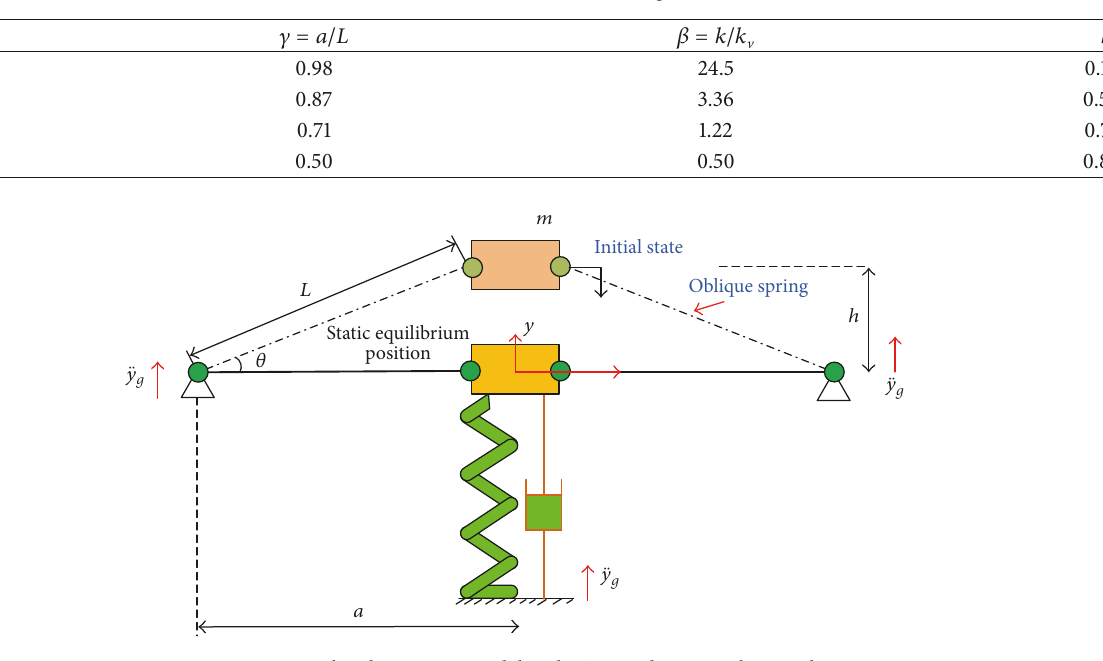
Figure 4: Seismic isolated structure model with QZS under vertical ground